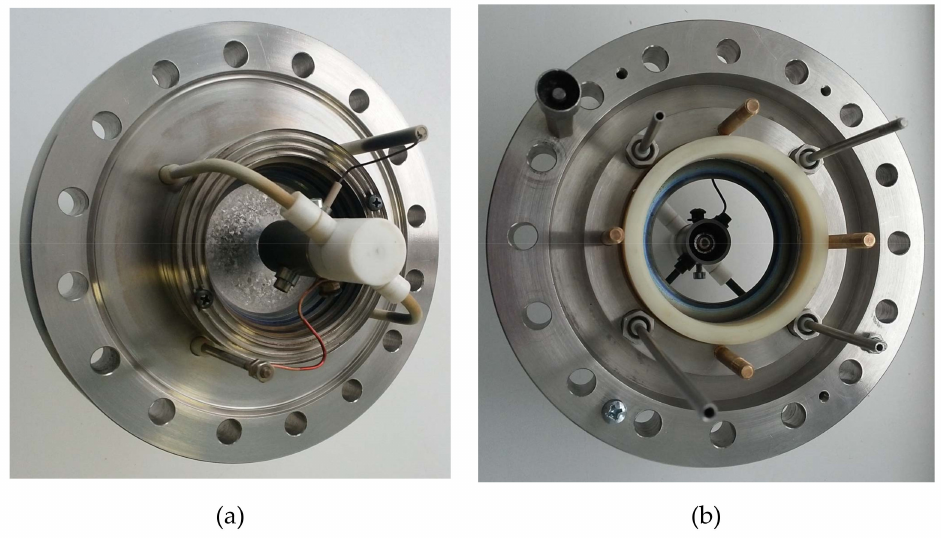
Figure 2. ( a ) External view of the ion source plasma generation system; ( b ) View of the vacuum arc plasma generator as seen from the magnetron